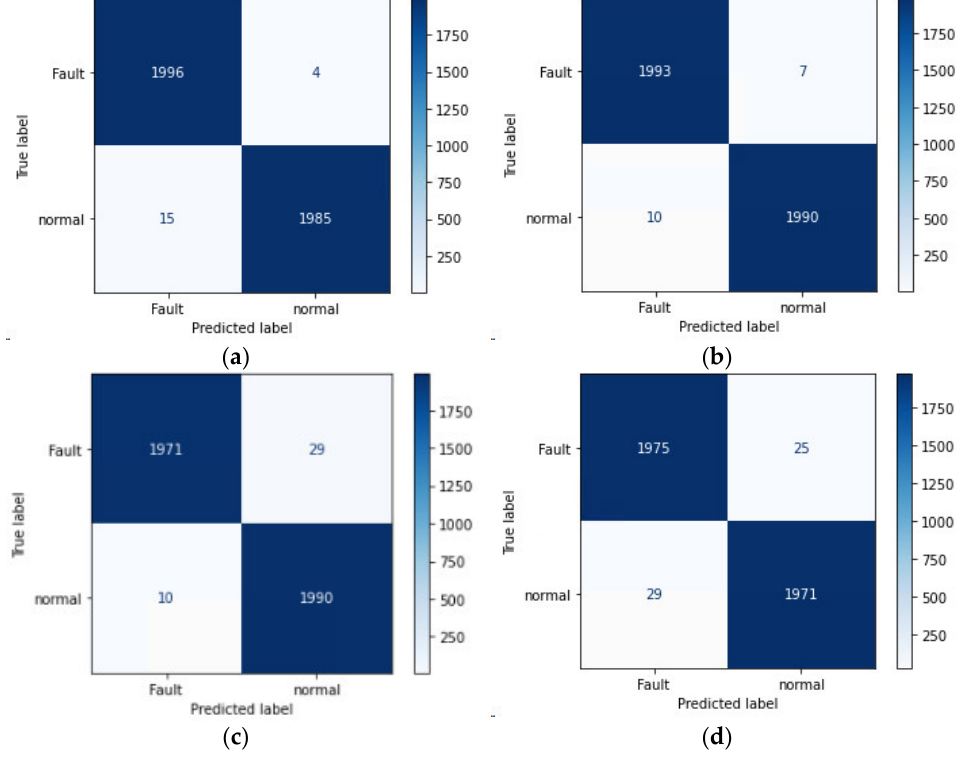
Figure 14. Prediction of Confusion Matrix, they should be listed as: ( a ) Xception Test dataset; ( b ) VGG16 Test dataset; ( c ) VGG19 Test dataset; ( d ) ResNet50 Test dataset.